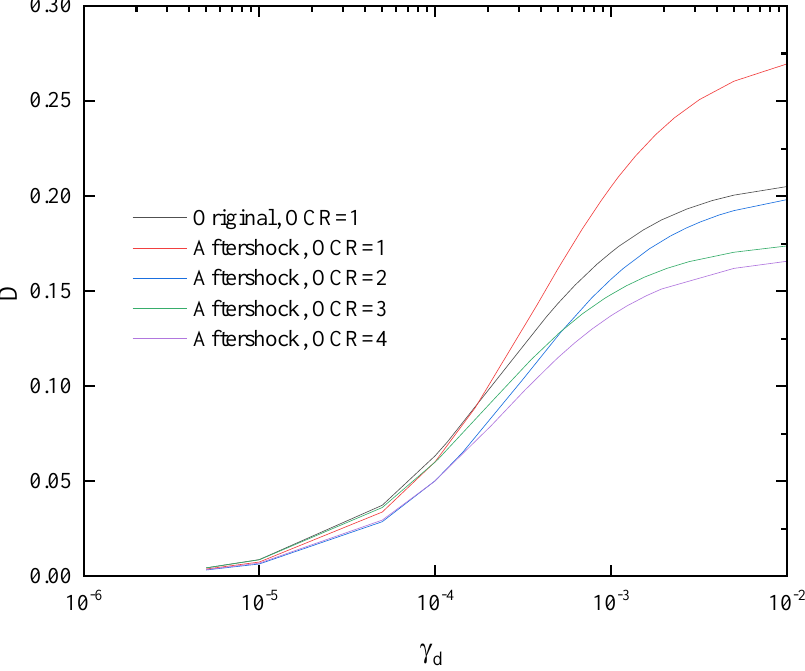
Figure 12. Normalized curves of the damping ratio versus the dynamic shear strain of the saturated loess under different test conditions.